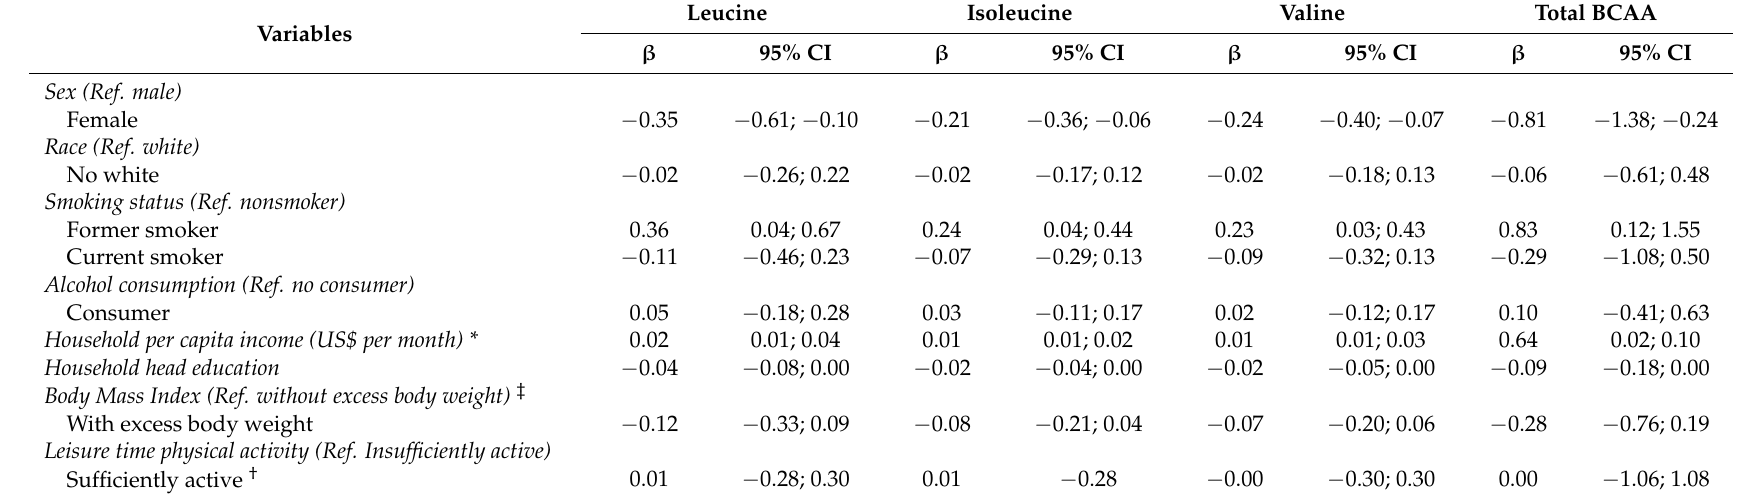
Table 2. Demographic, socioeconomic and lifestyle factors associated with branched chain amino acid intake in adults, ISA Capital, S ã o Paulo, Brazil, 2008. Leucine Isoleucine Valine Total Variables